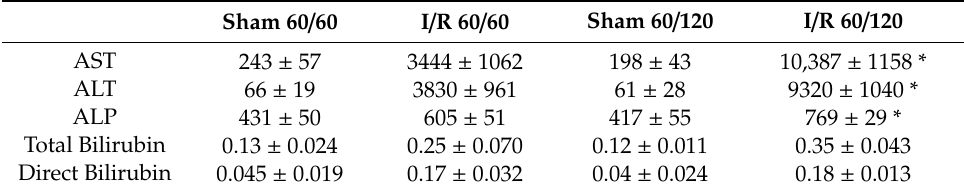
Table 1. Serum levels of AST, ALT, ALP (U/L), and total and direct bilirubin (mg/dL). Sham 60/60